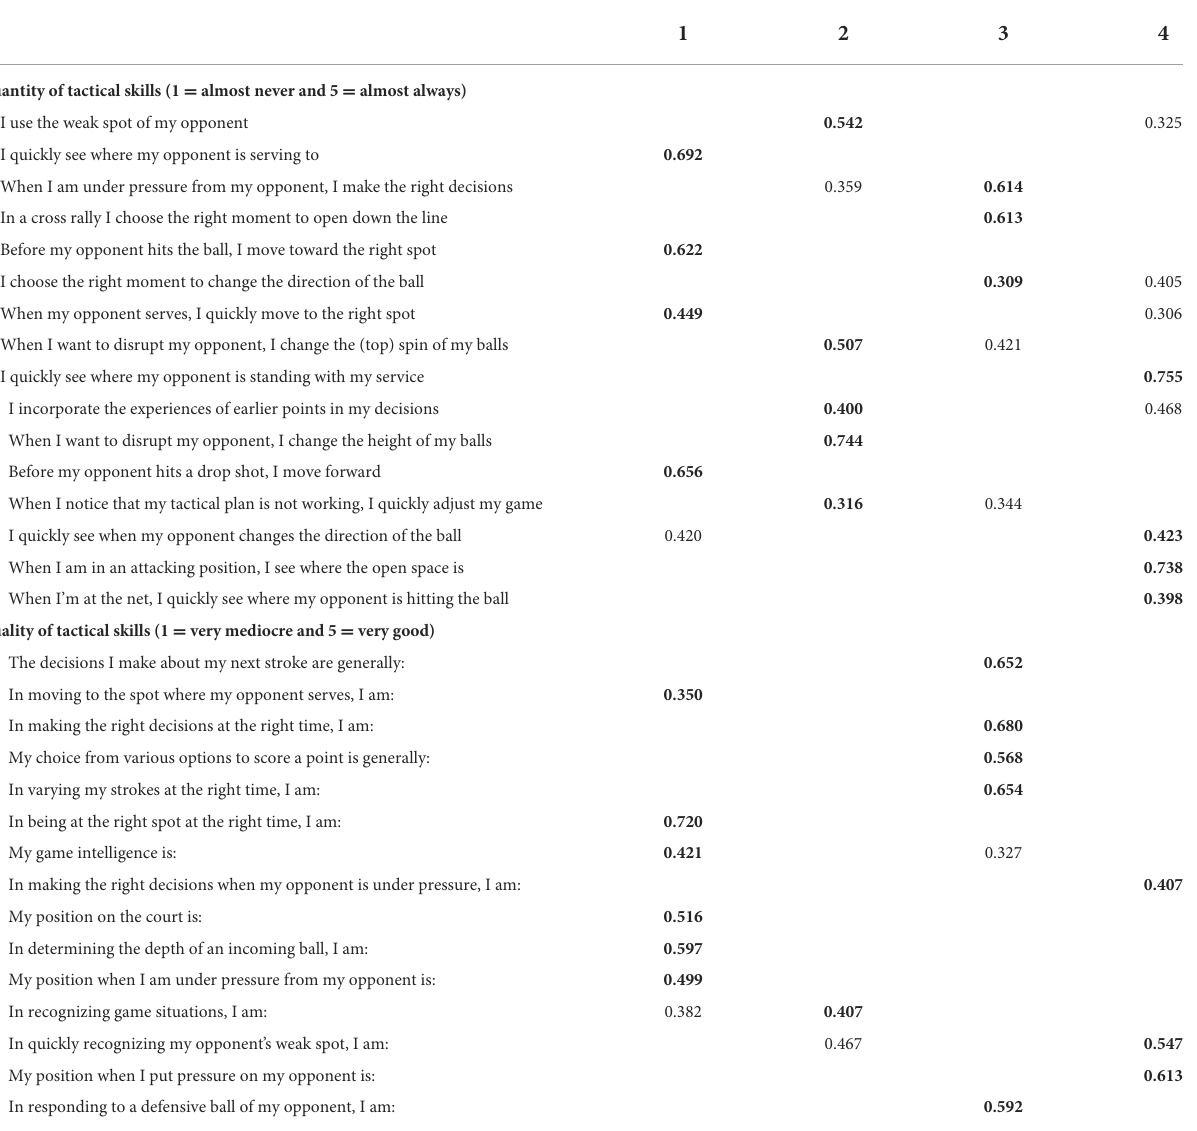
TABLE 1 Items and pattern loadings of the